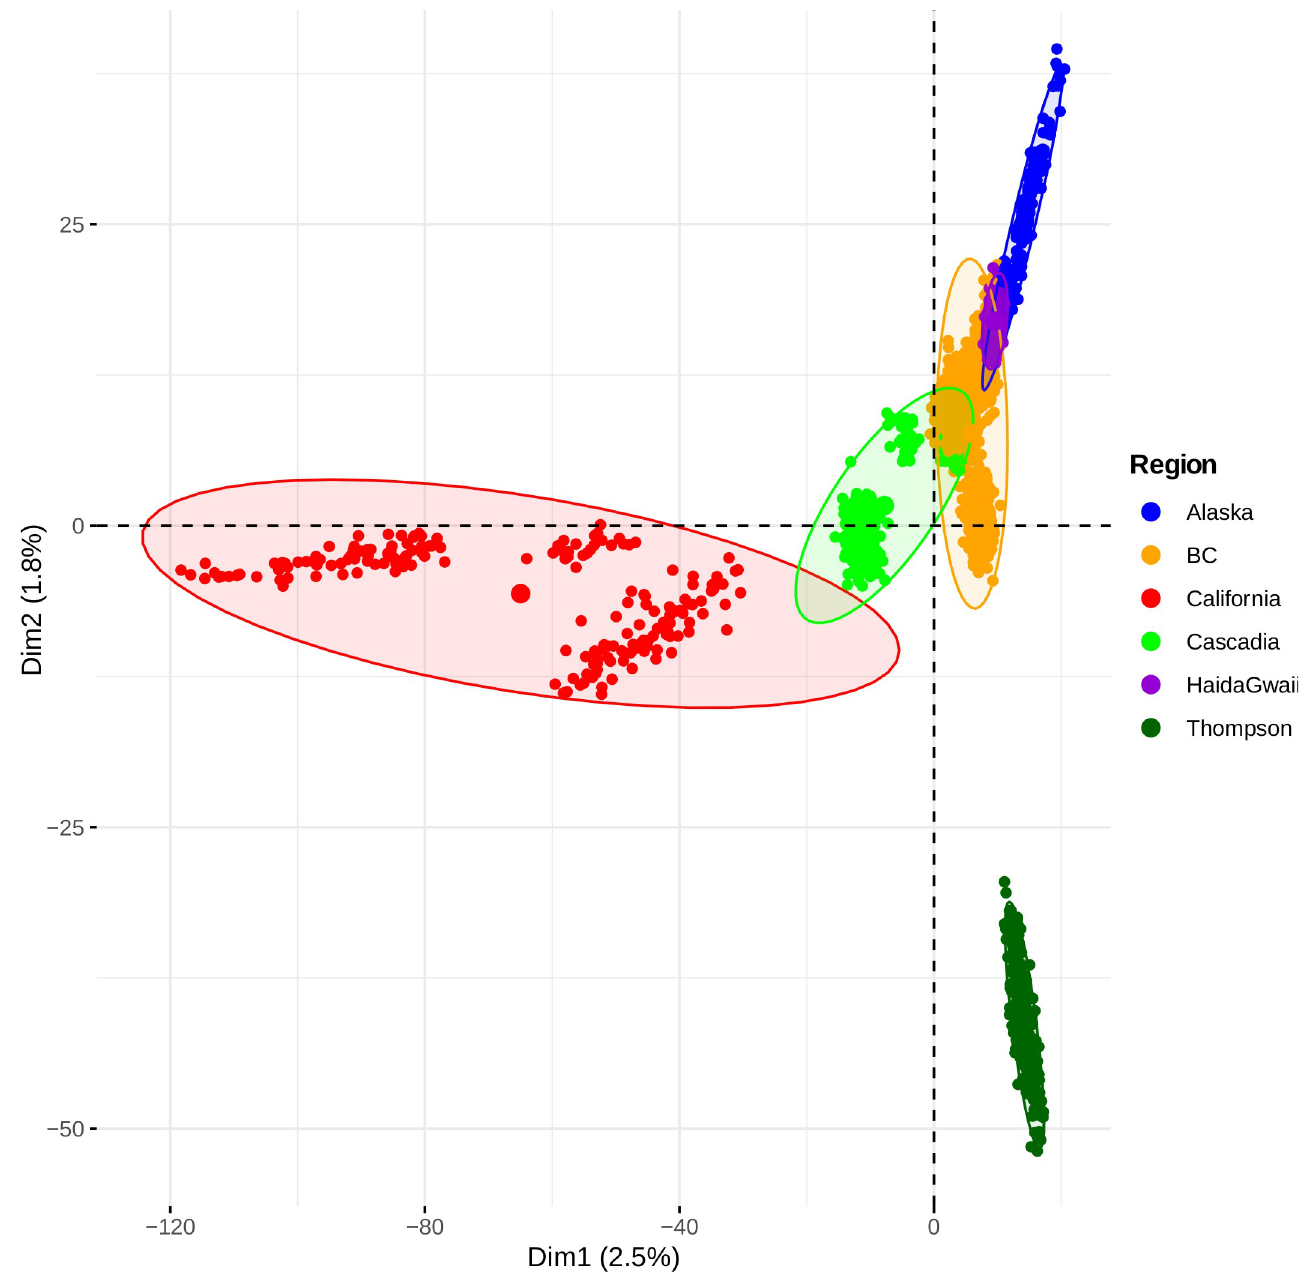
Fig 3. Genetic structure and gene flow. Principal Component Analysis (PCA) summarizing population genetic structure among 1,957 individuals based on the principal component axis 1 and axis 2. Each point represents an individual and the colours represent the major regional groups. The larger point represents the barycentre of each